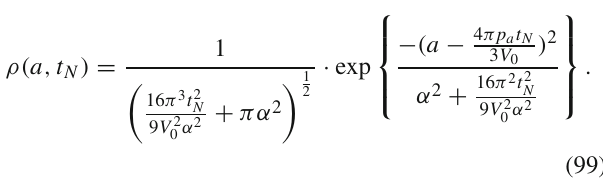
Fig. 15 Variations in the quantum fluctuation versus the coherence. The horizontal axis represents the coherence. The parameters are taken as: p a = 5, α = 0 . 5, V 0 =